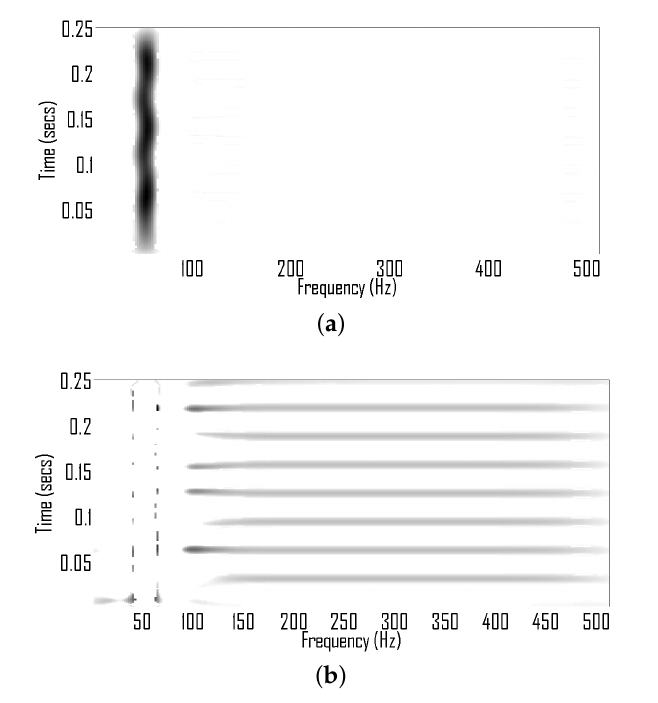
Figure 3. Separation of TF representations of tone and spike using direction of signal energy ( a ) TF representation of tone; and ( b ) TF representation of